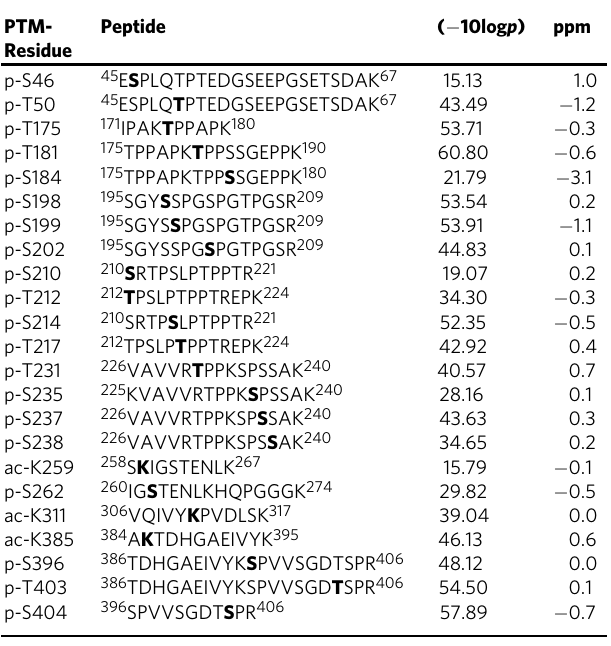
Tau proteins were isolated from AD brain extracts and puri fi ed for LC-MS/MS analysis to identify sites of tau phosphorylation and acetylation. The residue number, peptide sequence (bold denotes the modi fi ed residue), and signi fi cance values are depicted. The tau sequences listedarebasedonfull-lengthhuman2N4Rtau(441residues).Theproteincon fi dencescore p is represented as − 10Log p . Peptide mass accuracy is represented as parts per million